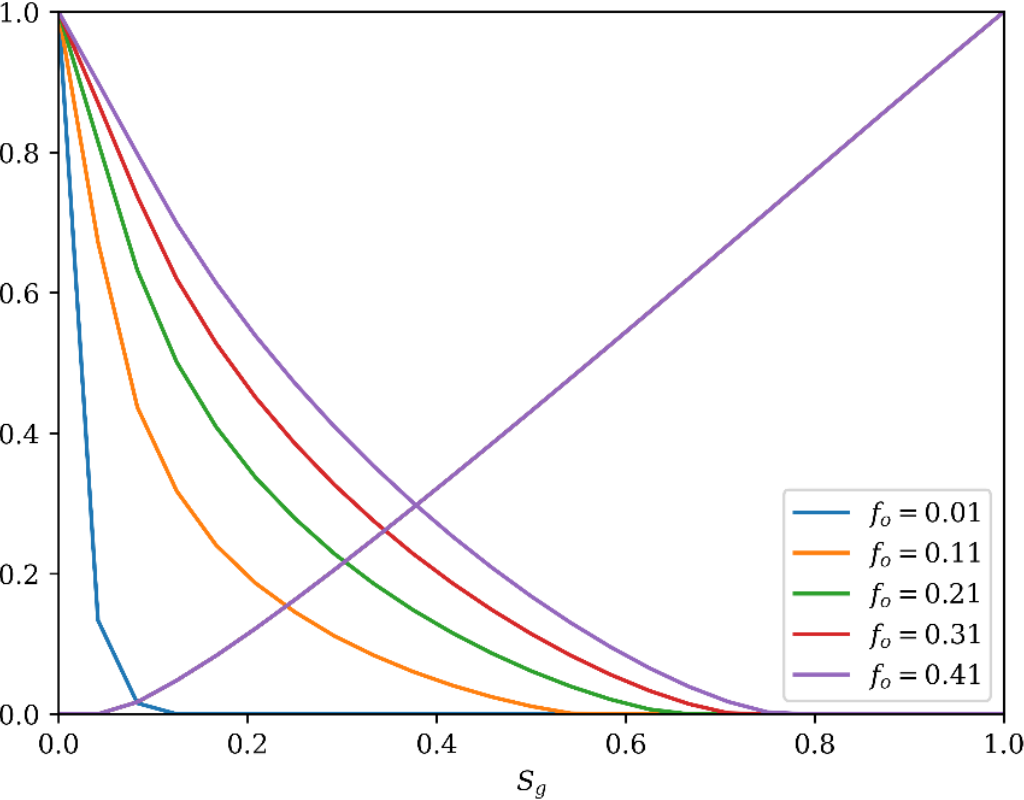
Figure 7. The sensitivity of the two-phase gas-oil relative permeabilities to changes in oil threshold ratios f o , for fixed f g = 0.1, Z =